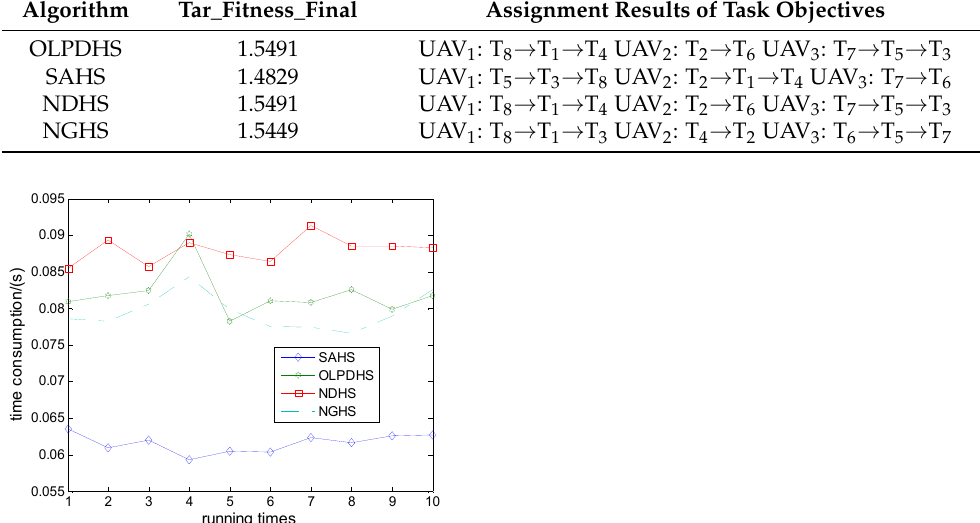
Table 8. Assignment results of task objectives corresponding to optimal fitness.